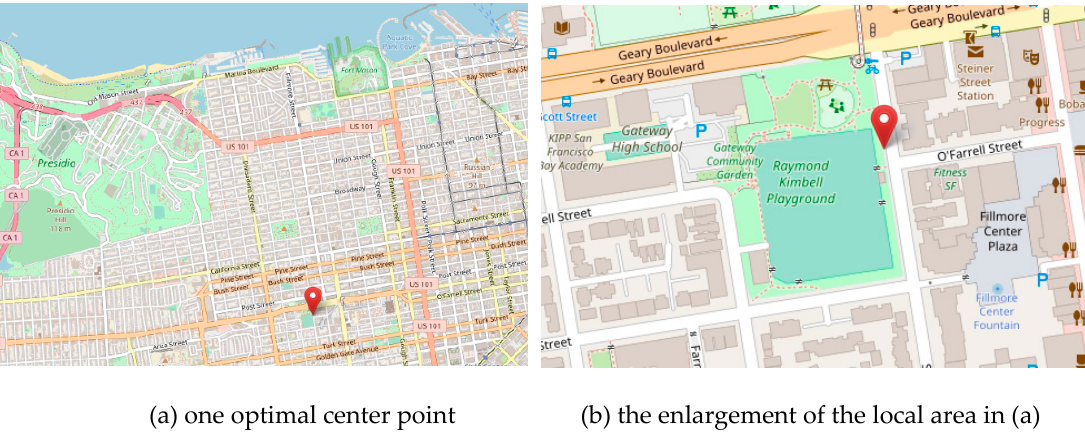
Figure 12. Example of one optimal center point in the running result of Figure 10a. (b) is the enlargement of the local area in (a).